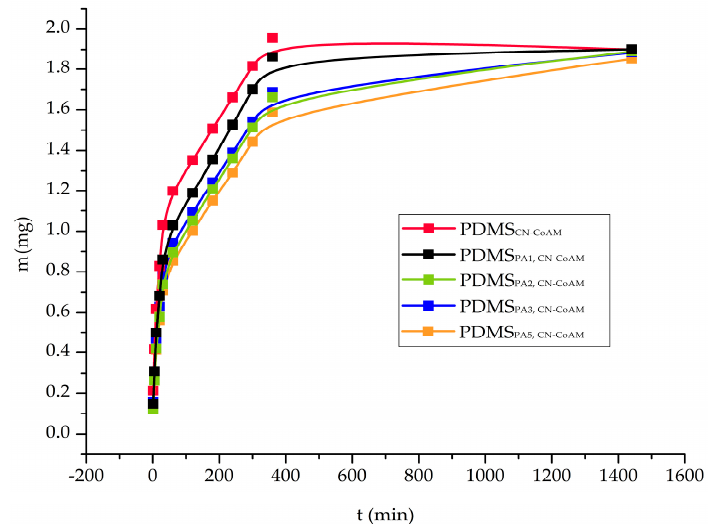
Figure 5. Time-dependent change in the cumulative released mass of the incorporated drug.